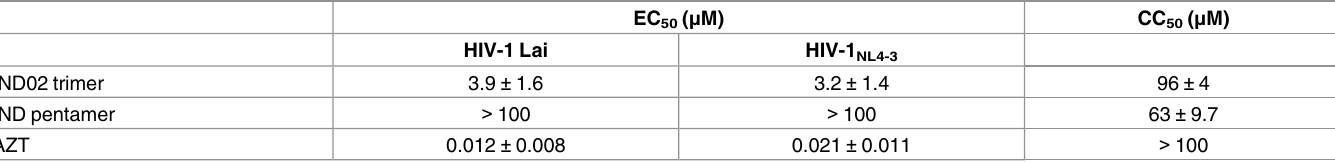
Table 1. Anti-viral activity of IND02 and AZT against HIV-1 LAI and NL4-3.